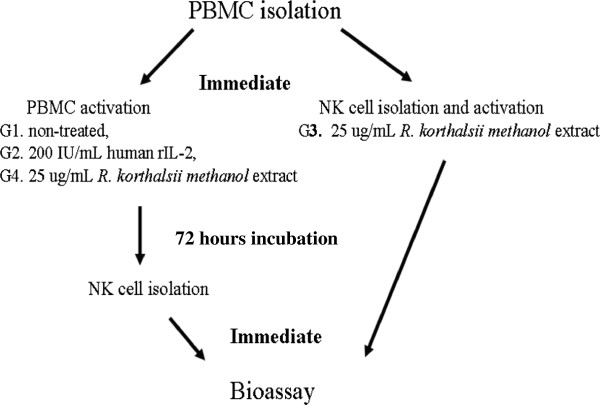
Brief description of NK cells treatment. G1 to G4 are the groups of treatment. Direct and indirect activations of R. korthalsii against NK cells were studied through isolation of NK cells before and after 72-hour incubation with the extract.